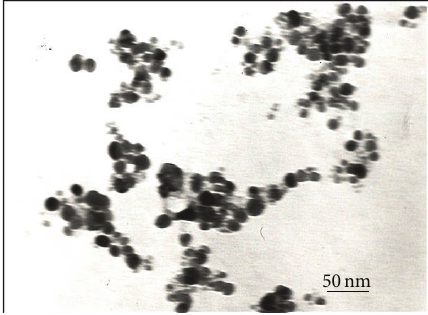
Figure 8: TEM image shows biosynthesized AgNps by endophytic fungi, Penicillium sp.